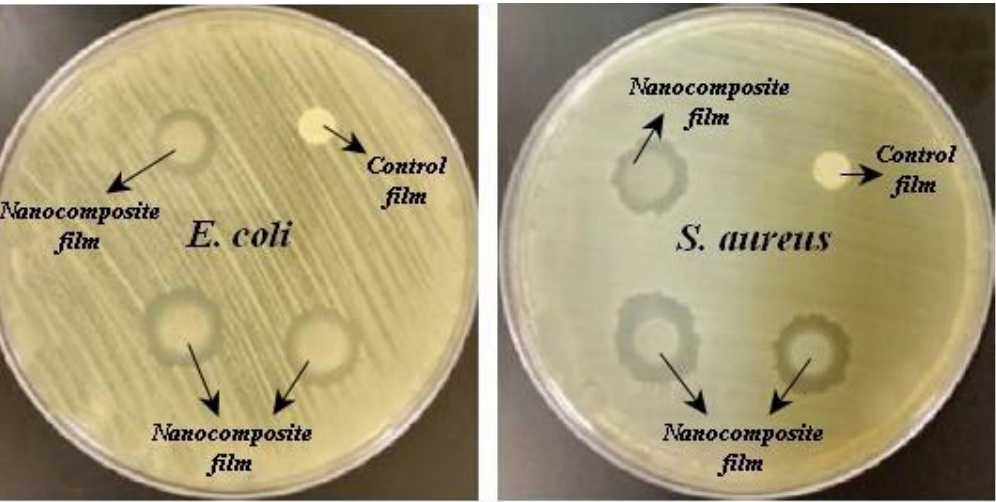
Figure 5. Antimicrobial activity of the SPI/PG/SNPs nanocomposite film against E. coli and S. aureus .